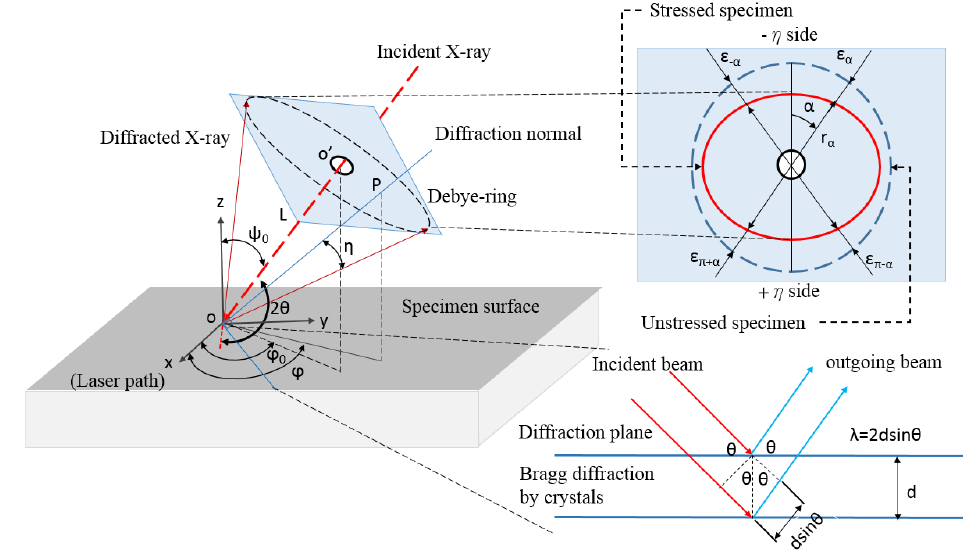
Figure 6. Illustration for the residual stress measurement by X-ray diffractometer .